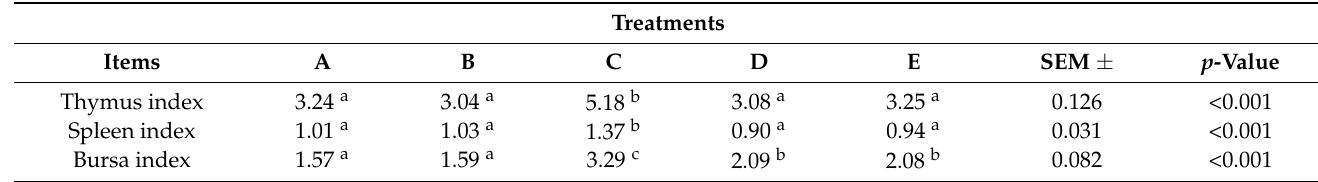
Table 6. GA decreased MG-induced immune organ indexes in the broilers.